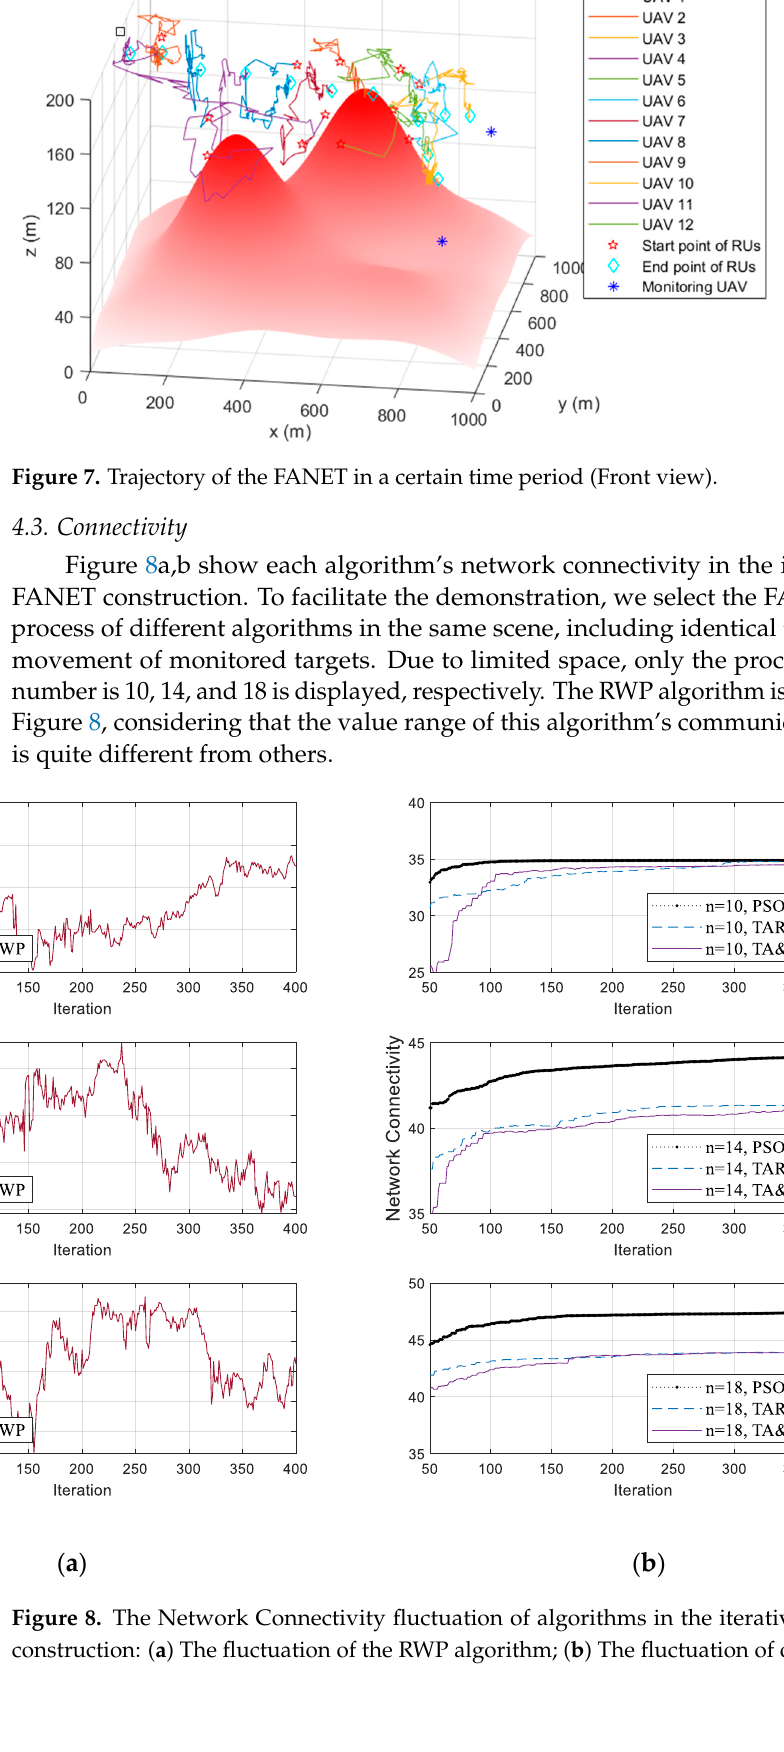
Figure 7. Trajectory of the FANET in a certain time period (Front view).